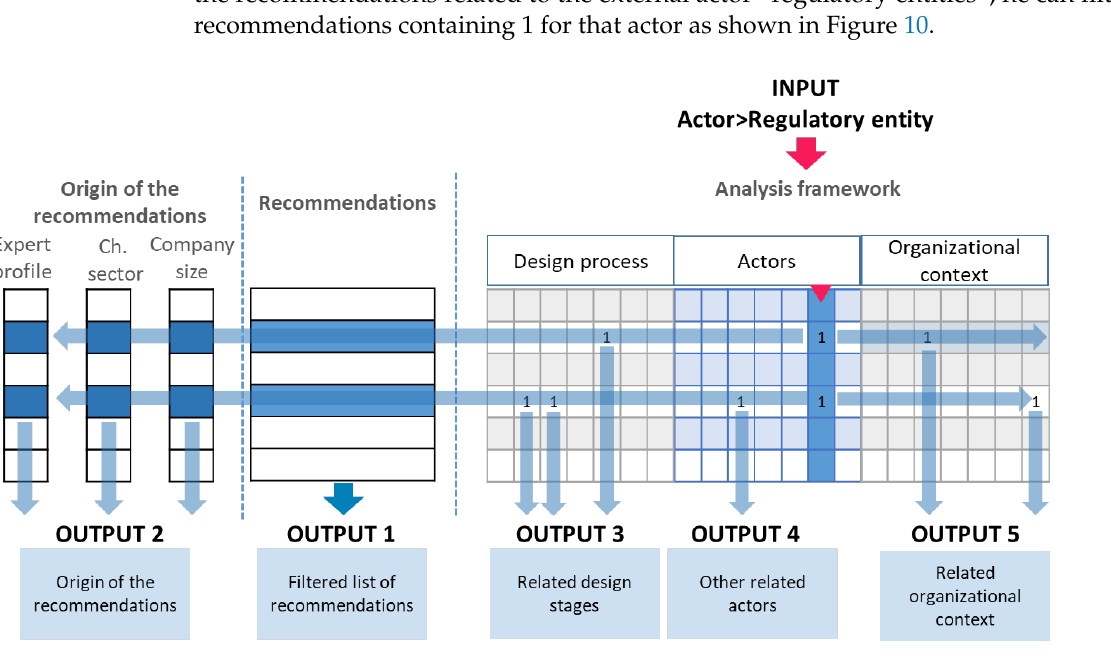
tor “regulatory entities” . “regulatory